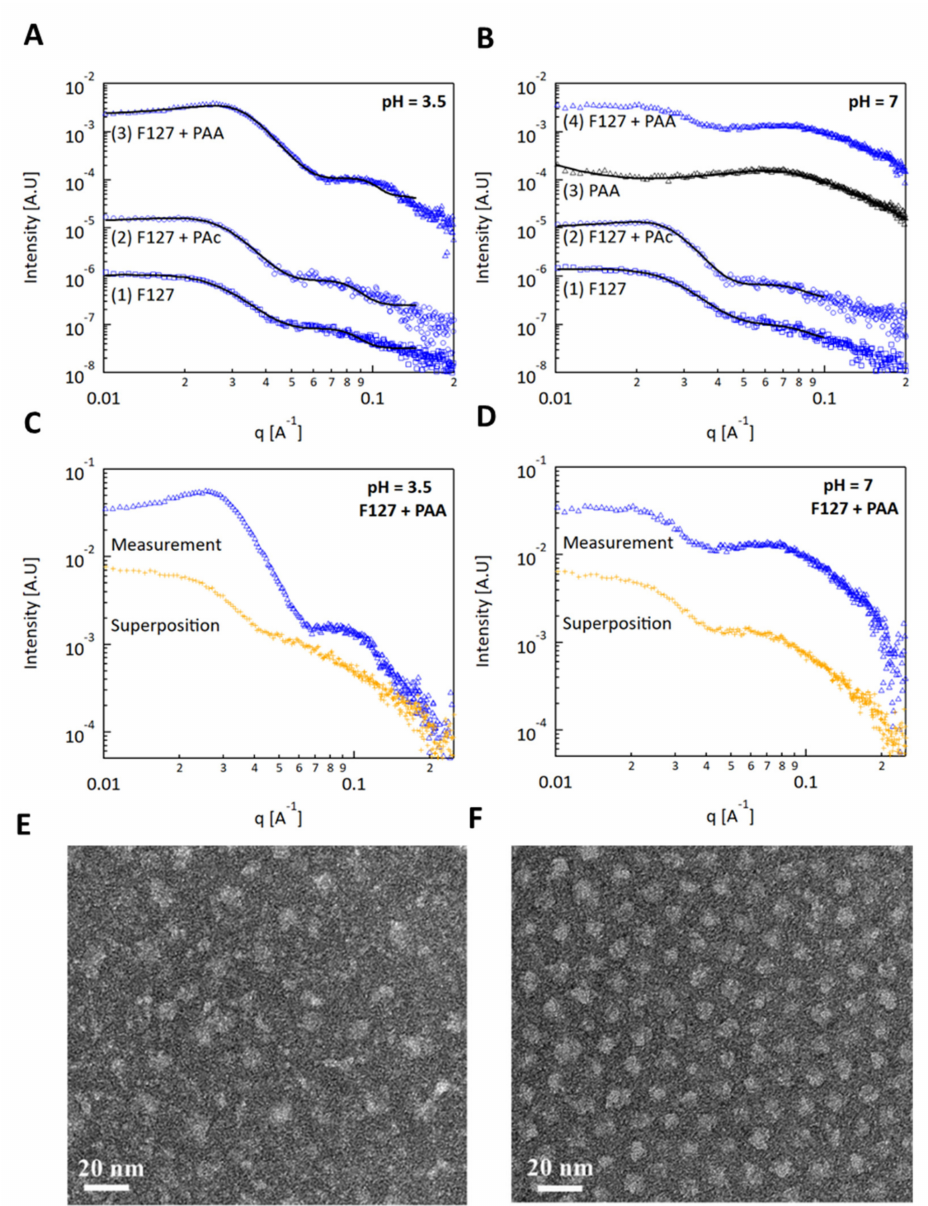
Figure 5. SAXS and TEM measurements of mixtures of F127 (5wt %) with 1 wt % PAA (30 kDa) and PAc (1 wt %). ( A ) 1D SAXS curves obtained from solutions at pH = 3.5 of (1) 5 wt% F127 ( (cid:3) ) (2) 5 wt% F127 + 1 wt% PAc (